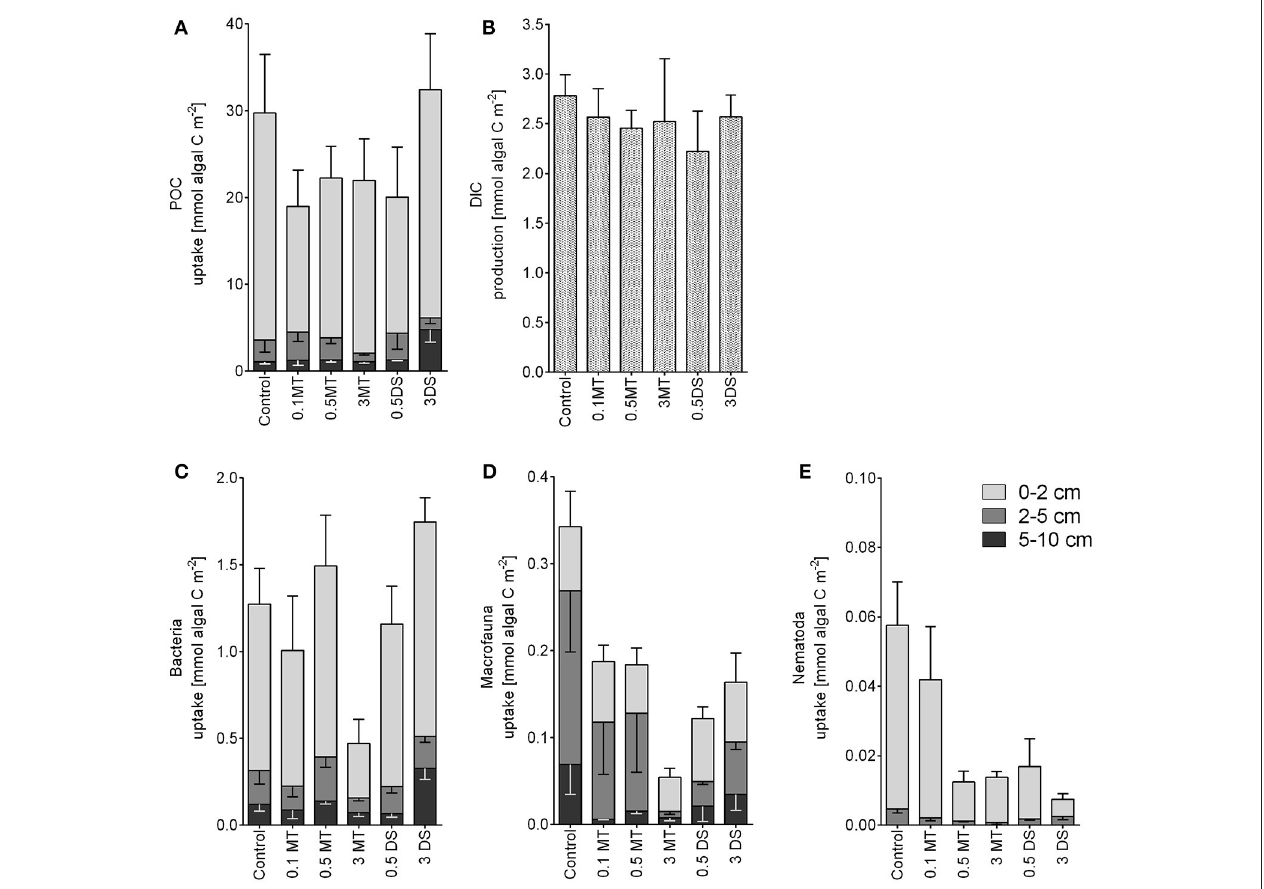
FIGURE 8 | Particulate organic carbon (POC, A) per treatment and depth; (B) dissolved inorganic carbon (DIC, B) per treatment; and uptake of algal 13 C per depth and treatment of (C) Bacteria, (D) Macrofauna and (E) Nematoda. Error bars depict standard errors and point downwards for the 2–5cm and 5–10cm data for better visualization. Abbreviations: 0.1 MT = 0.1cm mine tailing addition, 0.5 MT = 0.5cm mine tailing addition, 3 MT = 3 cm mine tailing addition, 0.5 DS = 0.5cm dead sediment addition, 3 DS = 3cm dead sediment